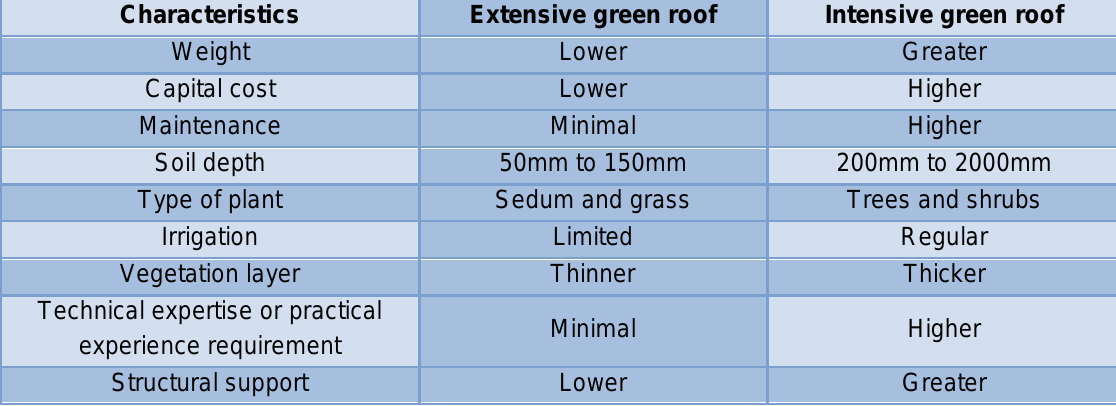
Table 1 Characteristics of Extensive and Intensive Green